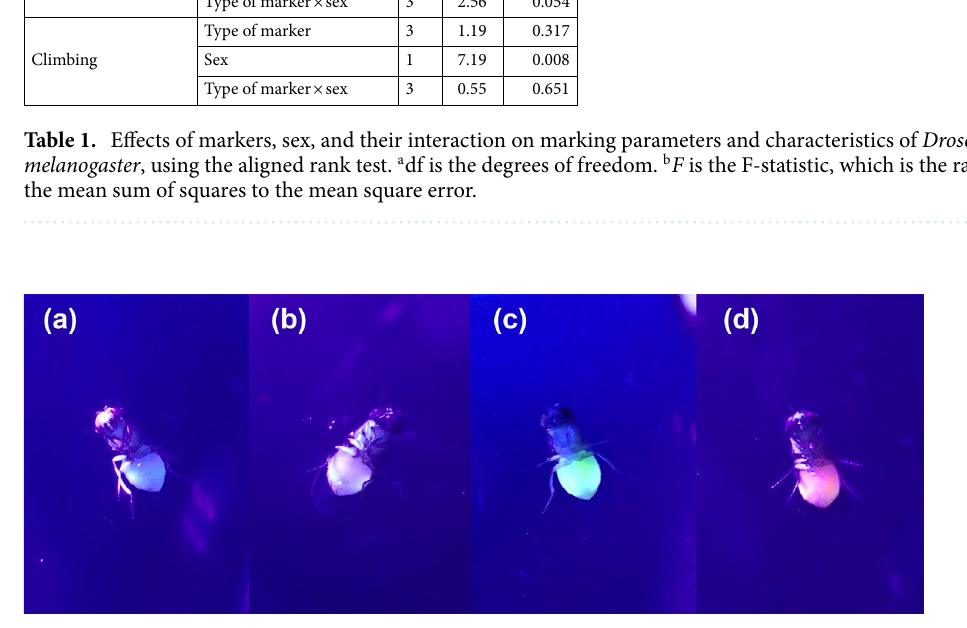
Figure 4. Drosophila melanogaster under a 40 W UV light bulb (365–400 nm wavelength) at a distance of 30 cm away after feeding liquid food containing different fluorescent markers for 1 h, ( a ) liquid food without a marker, ( b ) liquid food containing 0.27 mM Rubpy dye, ( c ) liquid food containing 0.27 mM fluorescein, and ( d ) liquid food containing 1 mg/mL